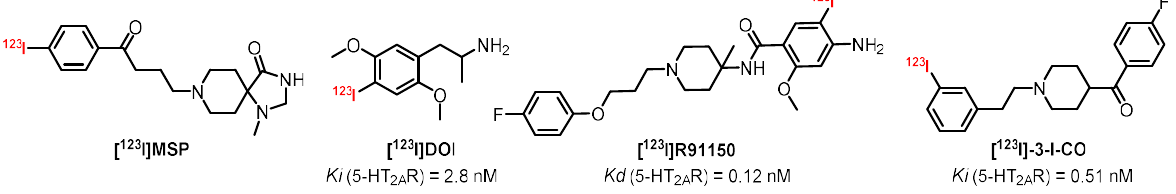
Figure 9. Miscellaneous 5-HT 2A R SPECT imaging tracers.